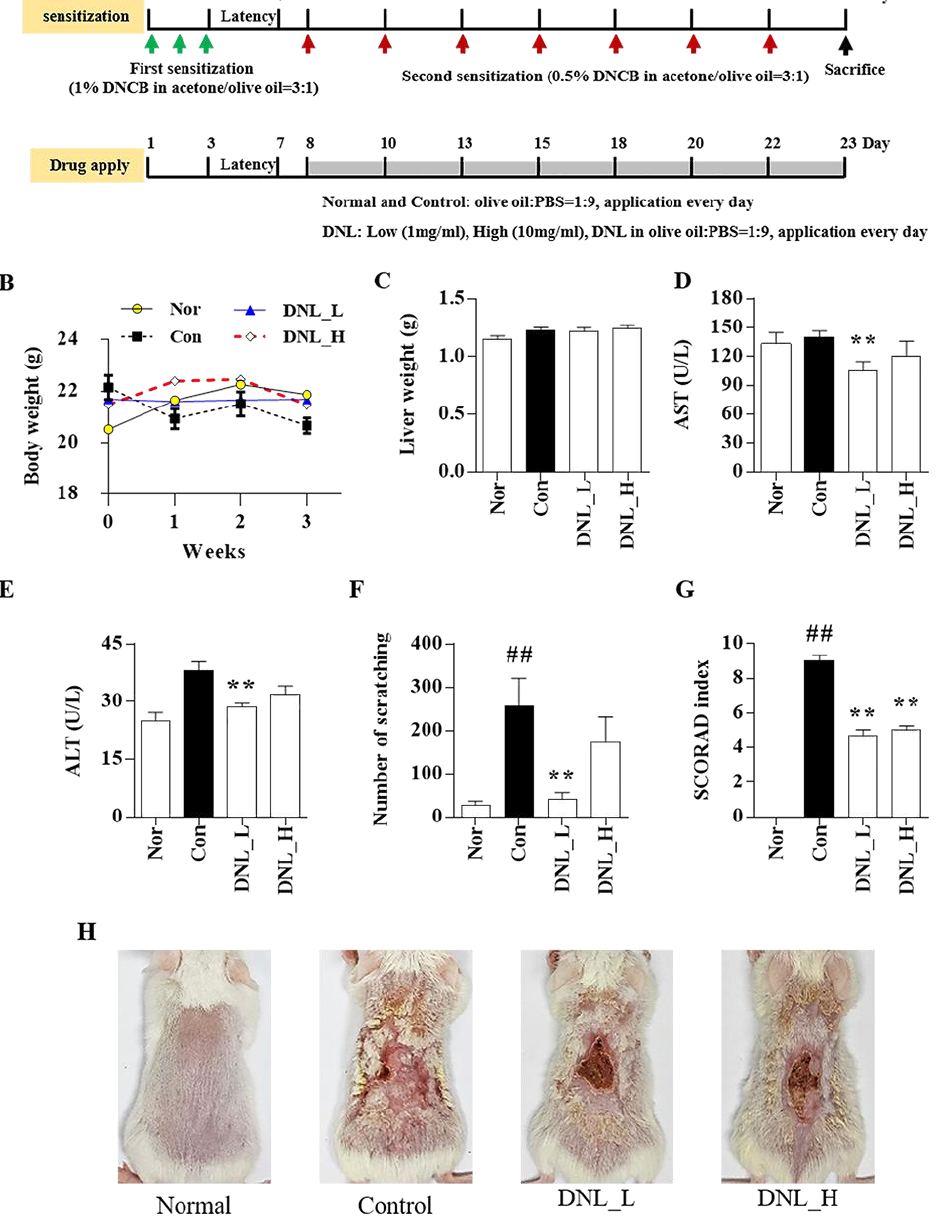
Figure 1. The toxicity of DNL and effect of DNL on scratching behavior and SCORAD index in DNCB-treated Balb/c mice. ( A ) Experimental schedule for topical application of DNL to dorsal skin. An amount of 1% DNCB was applied for three consecutive days to proceed with the first sensitization and had an incubation period of 4 days. After the incubation period, 0.5% DNCB was applied once every 2 or 3 days, DNL was applied every day, and sacrifices were performed on the 23rd day of the experiment. ( B ) The body weight of mice was measured using an electric scale once a week. ( C ) Liver weights were measured at the end of the animal experiment on the Balb/c mice DNL. ( D ) On the day of sacrifice, blood was collected through cardiac puncture, and serum was obtained by centrifugation. AST was confirmed by ELISA with the serum. ( E ) Serum ALT concentration was measured by